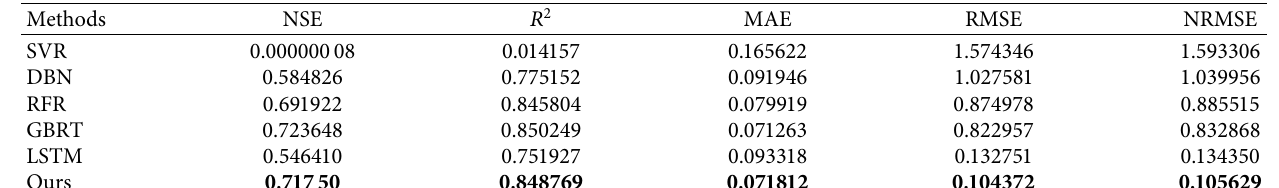
Table 3: Evaluation results for lead time of 24h.